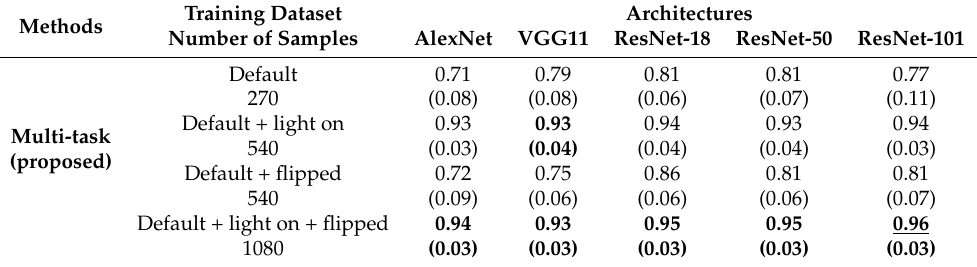
Figure 7. Illustrations of accuracy for ResNet-50: ( a , c , e ) are Task 1’s accuracy plots for different training data; ( b , d , f ) are Task 2’s accuracy plots for different training data. Table 7. Comparisons of results using the different training datasets, in terms of exact match ratio. The best values for each architecture are in bold and the best performing model among the architectures is